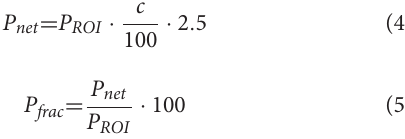
ROI and year. This percentage then allowed to estimate the fraction of precipitation due to forest cover (Equations 4 and